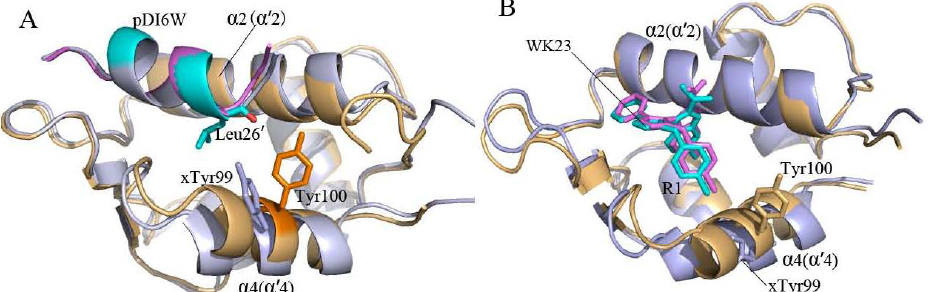
Figure 5. Stereoview of superimposed structures of inhibitor-MDM2 complex and inhibitor-MDMX complex. MDM2/MDMX and pDI6W are displayed in a cartoon mode, MDM2 is shown in light orange and MDMX in light blue, Leu26', Tyr99 of MDMX and Tyr100 of MDM2 are shown in stick. ( A ) pDI6W-MDM2/MDMX complex; ( B ) WK23-MDM2/MDMX complex. The character “x” before the residue represents this residue belongs to